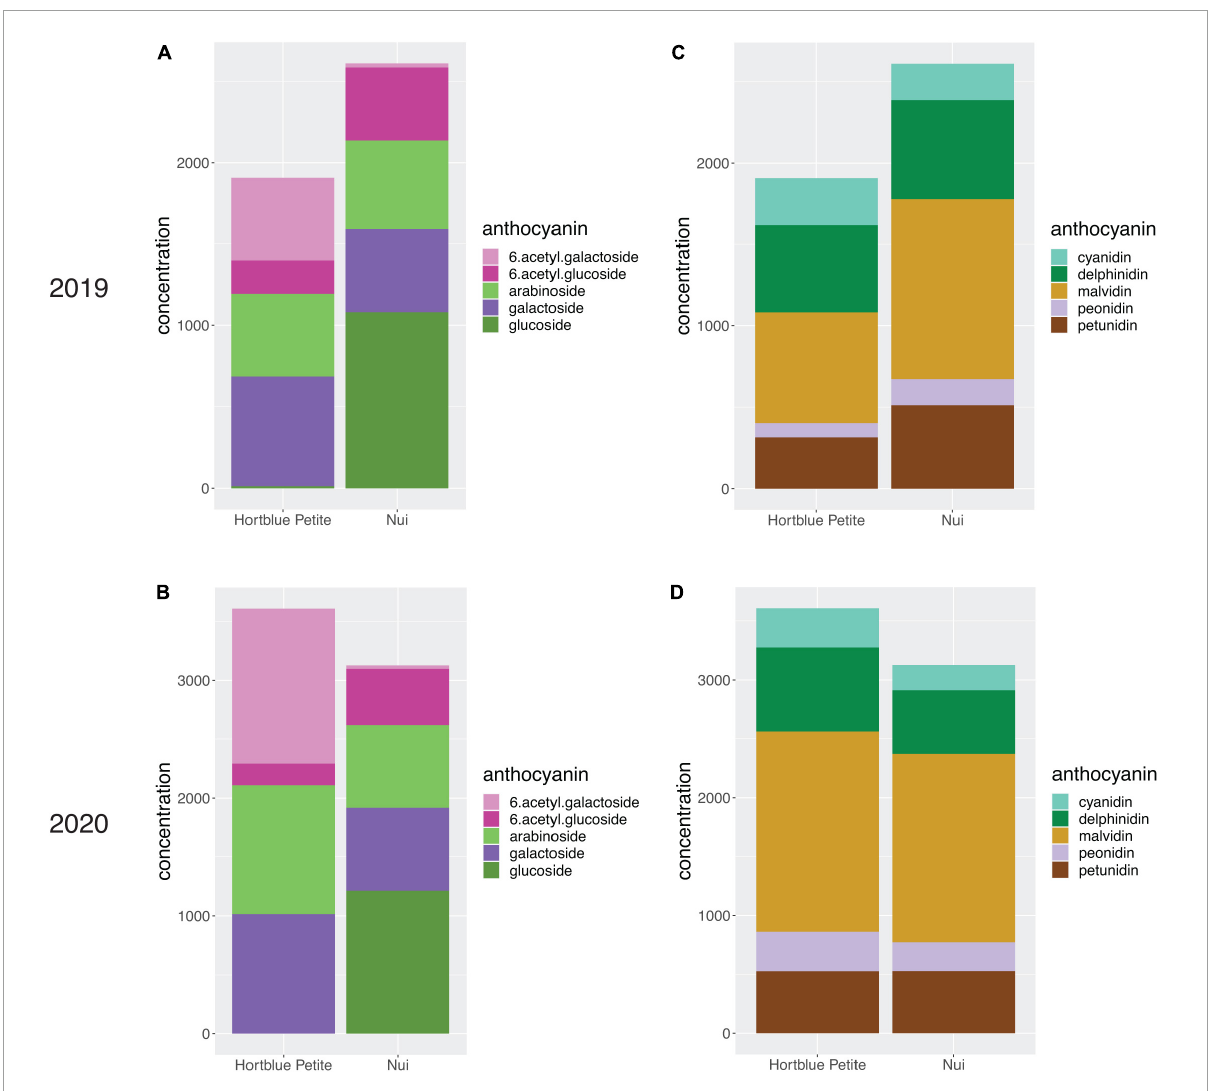
FIGURE3 Comparison of anthocyanin content ( µ g/g) between “Hortblue Petite” and “Nui”. The overall anthocyanin content, as well as the proportions of each group of anthocyanin based on their sugar (A,B) and aglycone (C,D) moieties, in 2019 and 2020 are shown with stacked barplots.